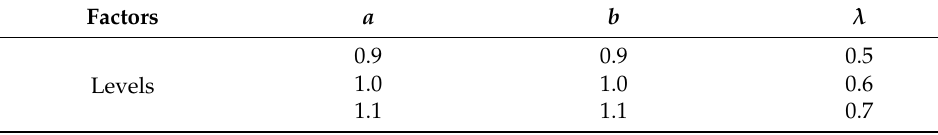
Table 2. Level values of every factor in orthogonal test.